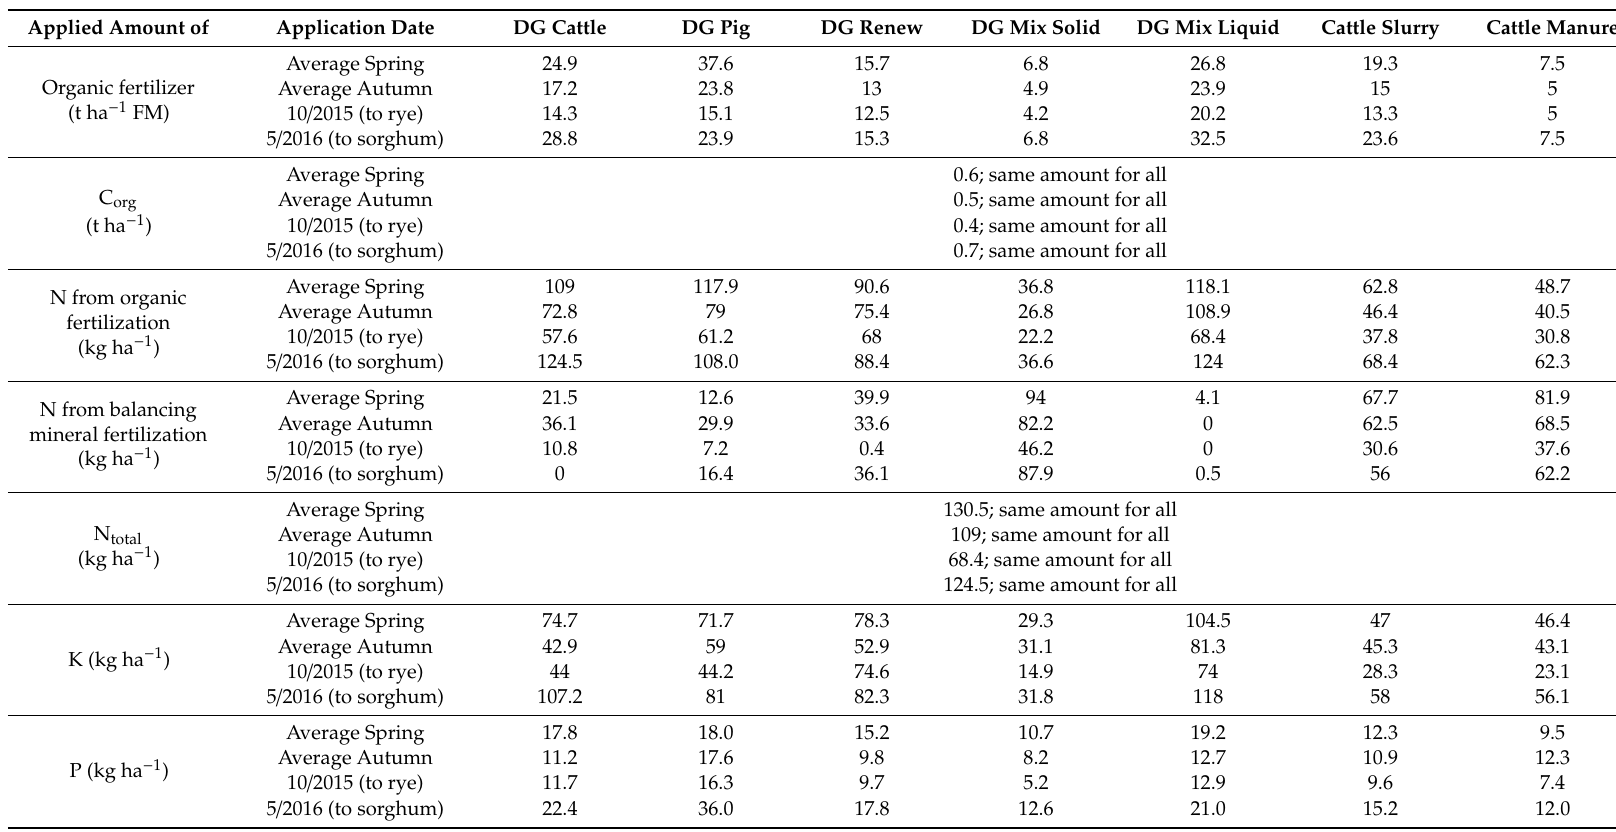
Table 2. Total amounts of organic fertilizers applied in the field trial and of the carbon, nitrogen, phosphorus, and potassium applied with them between spring 2011 and autumn 2016. Applied Amount of Organic fertilizer (t ha − 1